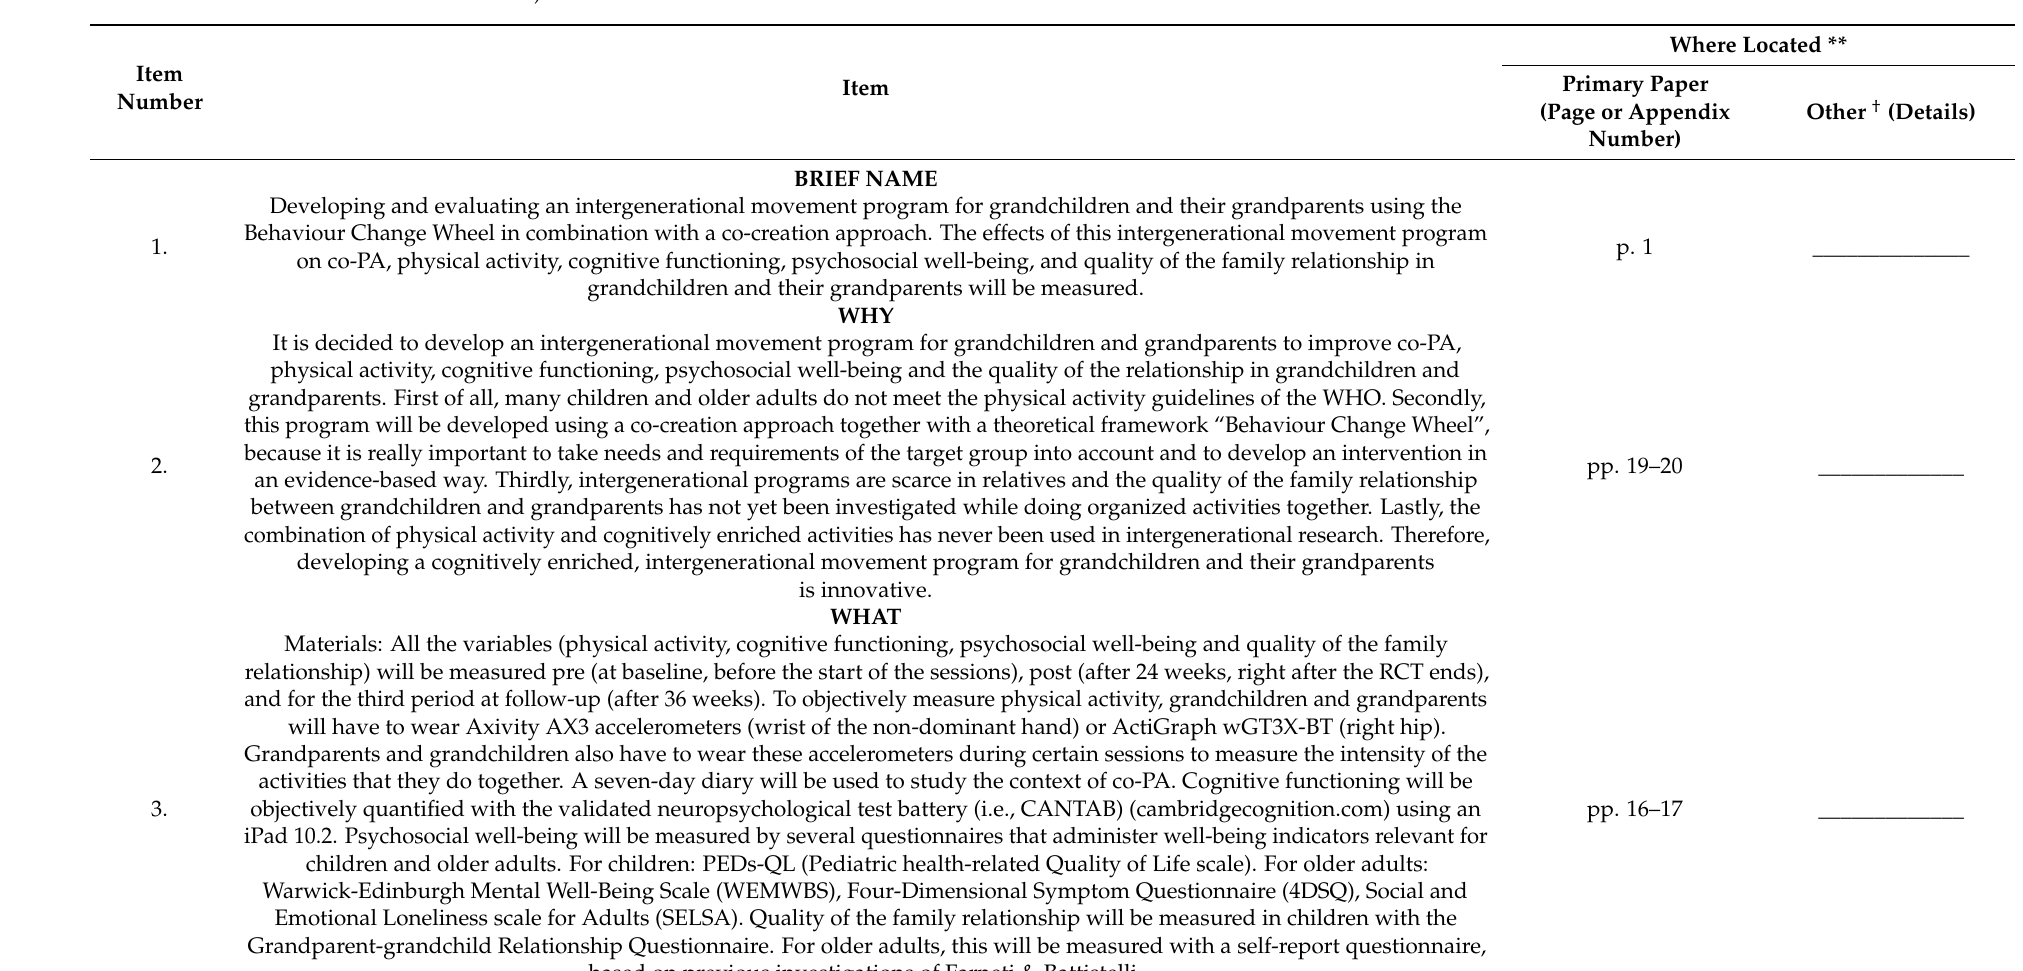
Table A1. TIDieR (Template for Intervention Description and Replication) Checklist. (Information to include when describing an intervention and the location of the